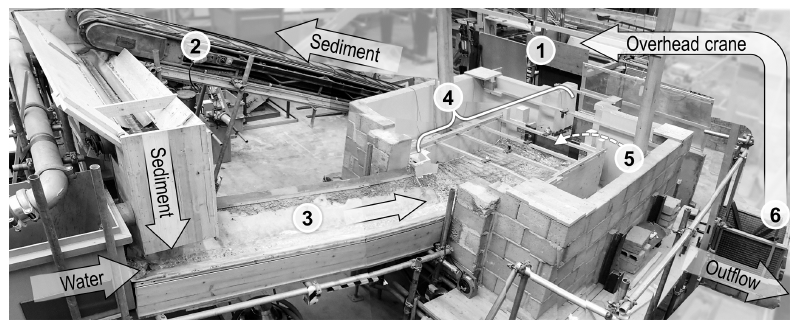
Figure 3. The experimental set-up with a sediment supply system that consisted of a sediment container (1) and conveyor belts (2); with indication of the water supply by the laboratory pump system, and the adaptation reach (3) that led the sediment–water mixture to the observation reach (4). The barriers were placed at the downstream end of the observation reach (5). The outflowing sediment and water were separated by a filter basket (6) at the downstream end of the